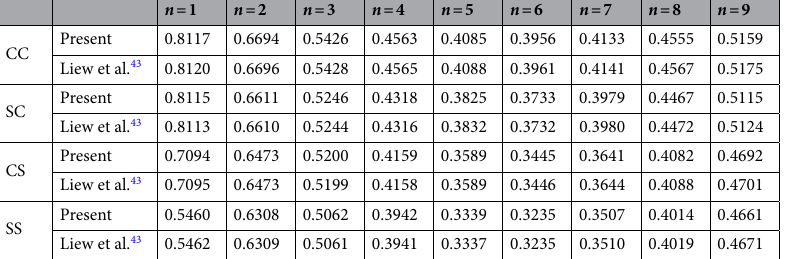
Table 2. First dimensionless natural frequency (Ω n1 = ω n1 b [ ρ (1 − ν 2 )/ E ] 0.5 ) of a homogenous isotropic truncated conical shell with various boundary conditions ( ν = 0.3, α = 45°, L sin α / b = 0.5, h / b = 0.01).